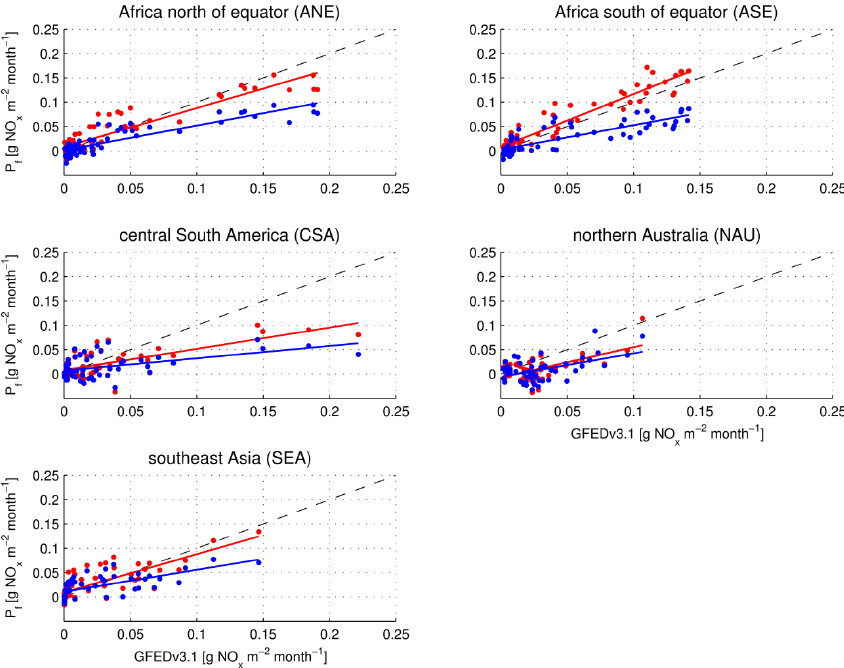
Figure 8. Scatter plots of the estimated monthly production rates of NO x from fires (P f ), retrieved from the GOME-2 (blue) and OMI (red) TVC NO 2 observations, against GFED3.1 NO x emission fields. The 1 : 1 line is shown by the dashed black line.